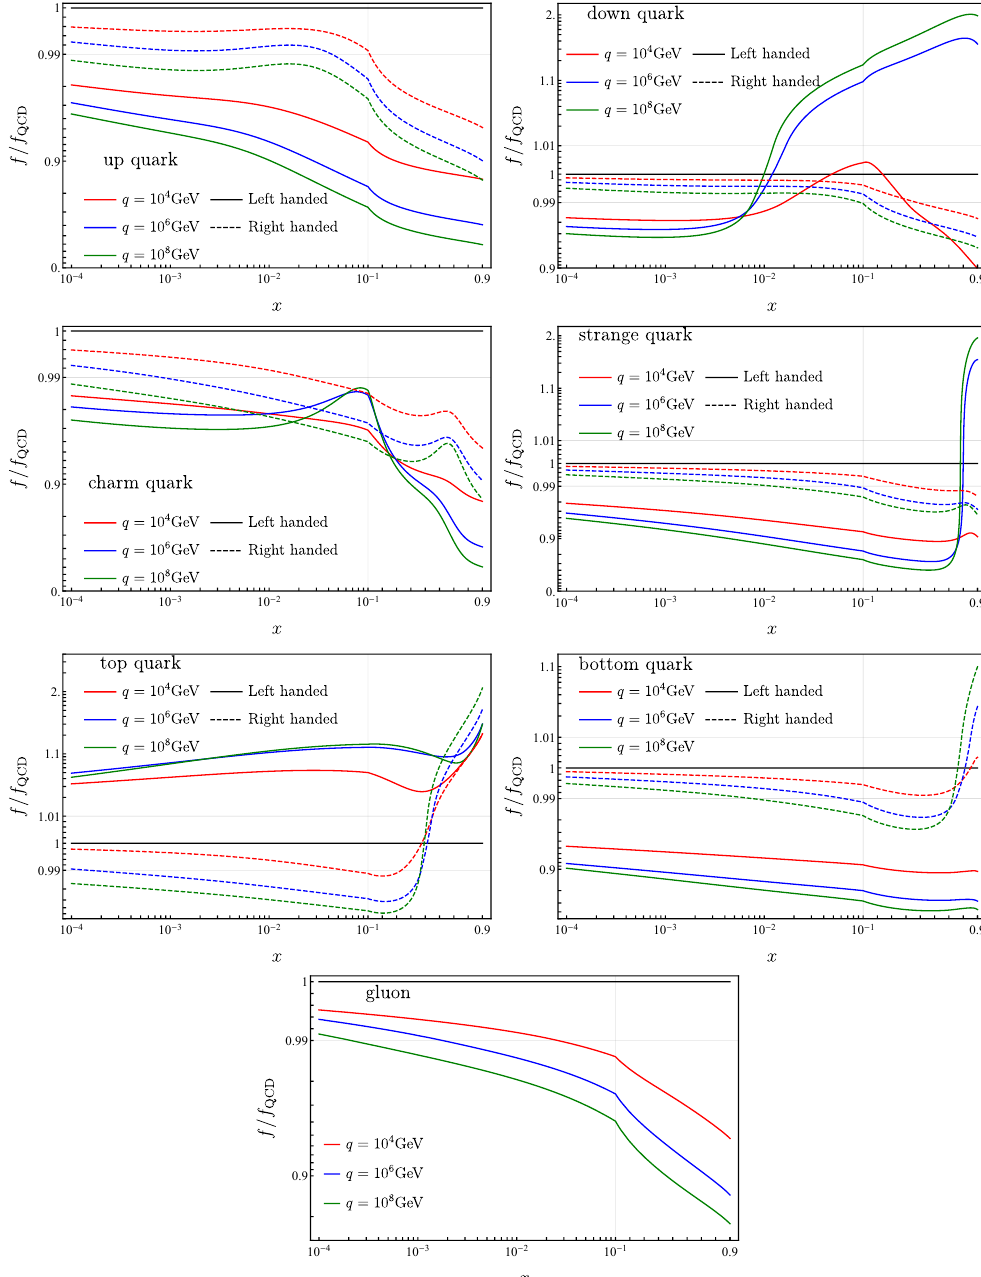
Figure 1 . Quark and gluon PDFs in the full unbroken SM, divided by their values assuming pure QCD evolution only. Left- and right-handed quark chiralities are solid and dashed, respectively. The thin gray lines show where the scales on the x- and/or y-axes switch between linear and logarithmic.